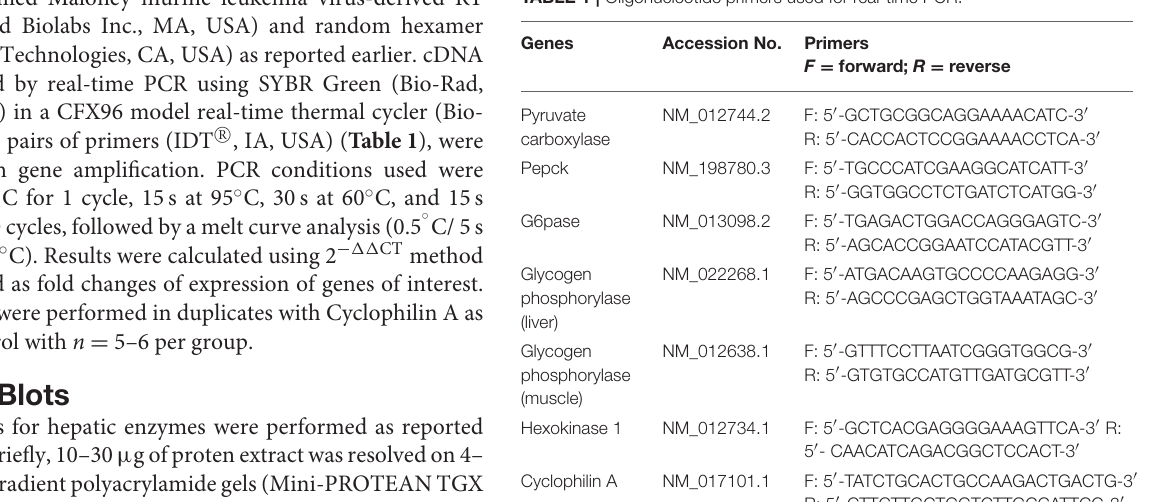
TABLE 1 | Oligonucleotide primers used for real-time